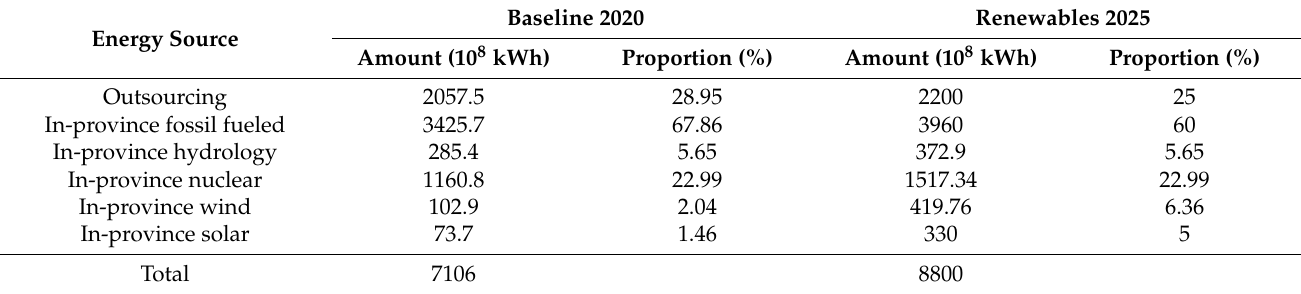
Table 1. Summary of scenario data for energy